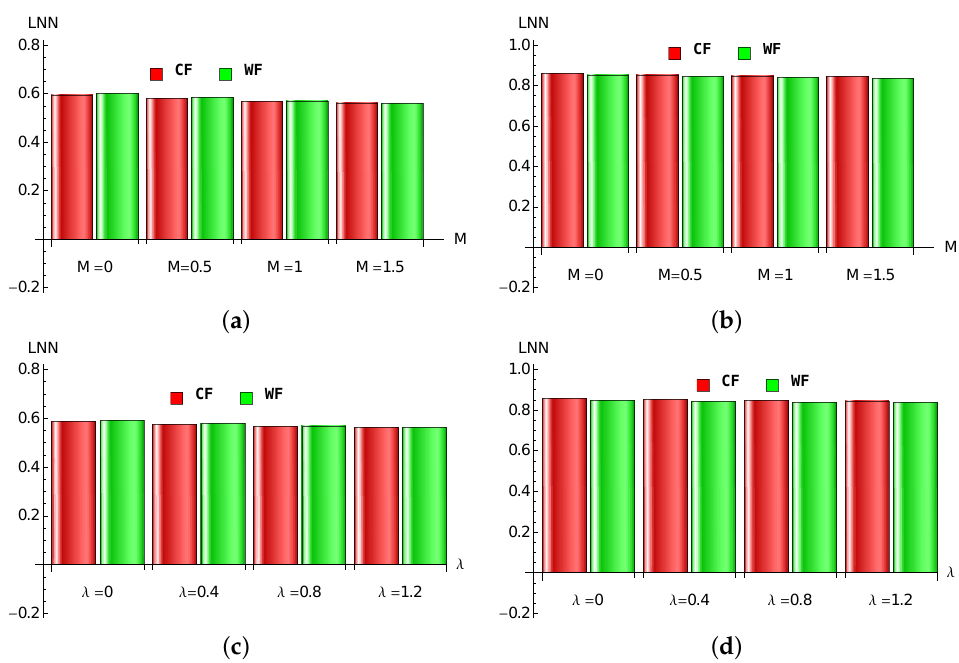
Figure 6. The local Nusselt number (LNN) for different values of M with fw = − 0.6 ( a ), M with fw = 0.6 ( b ), λ with fw = − 0.6 ( c ) and λ with fw = 0.6 ( d ) for Casson nanofluid (CF) and Williamson nanofluid (WF).